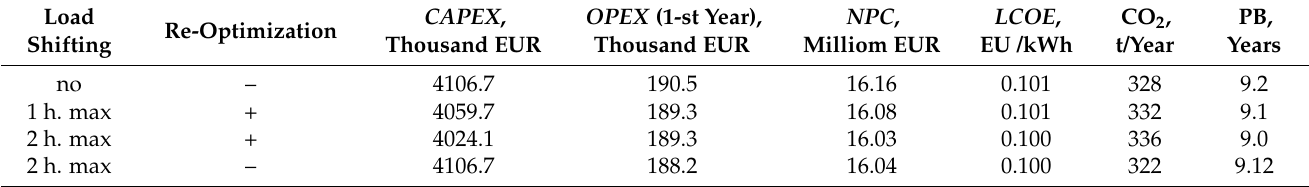
Table 12. Technical and economic indicators of HES configuration